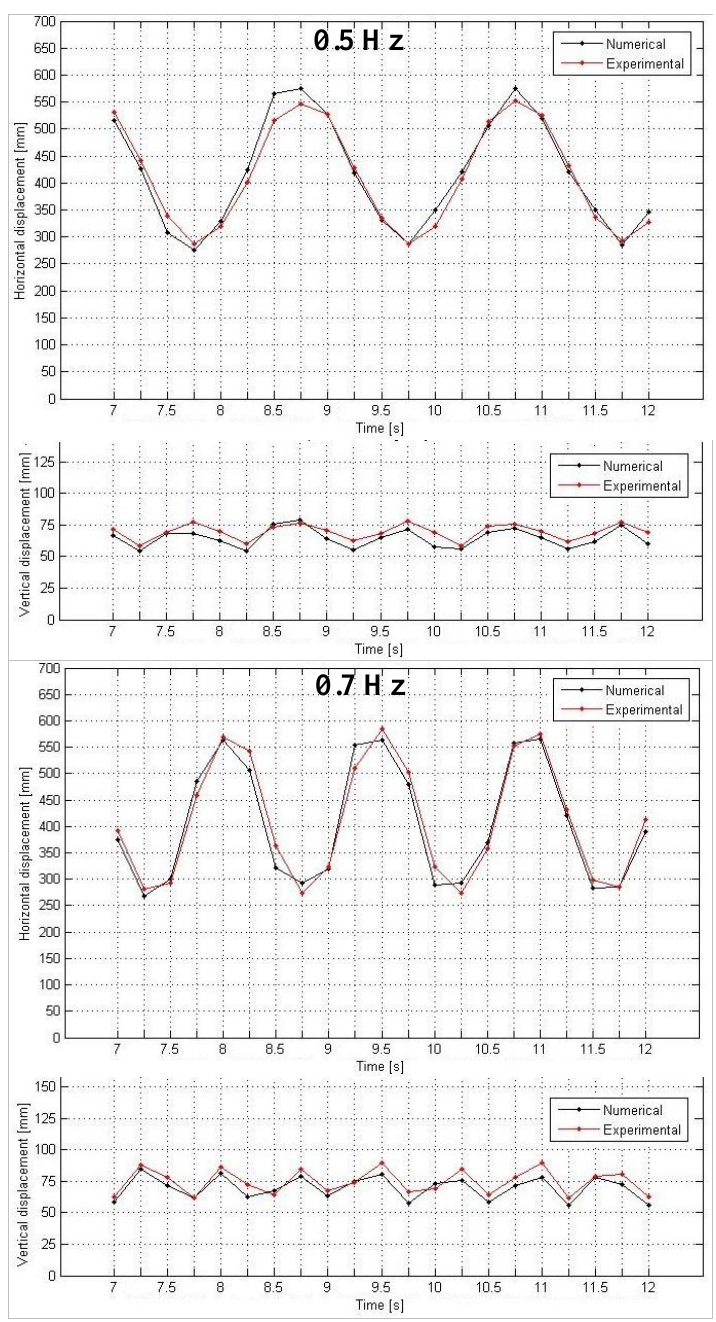
Figure 14. Comparison between numerical and experimental data in the time interval [7 ÷ 12] s: horizontal displacements and vertical displacements. Table 4. Model output for the center of gravity (Test 2) .